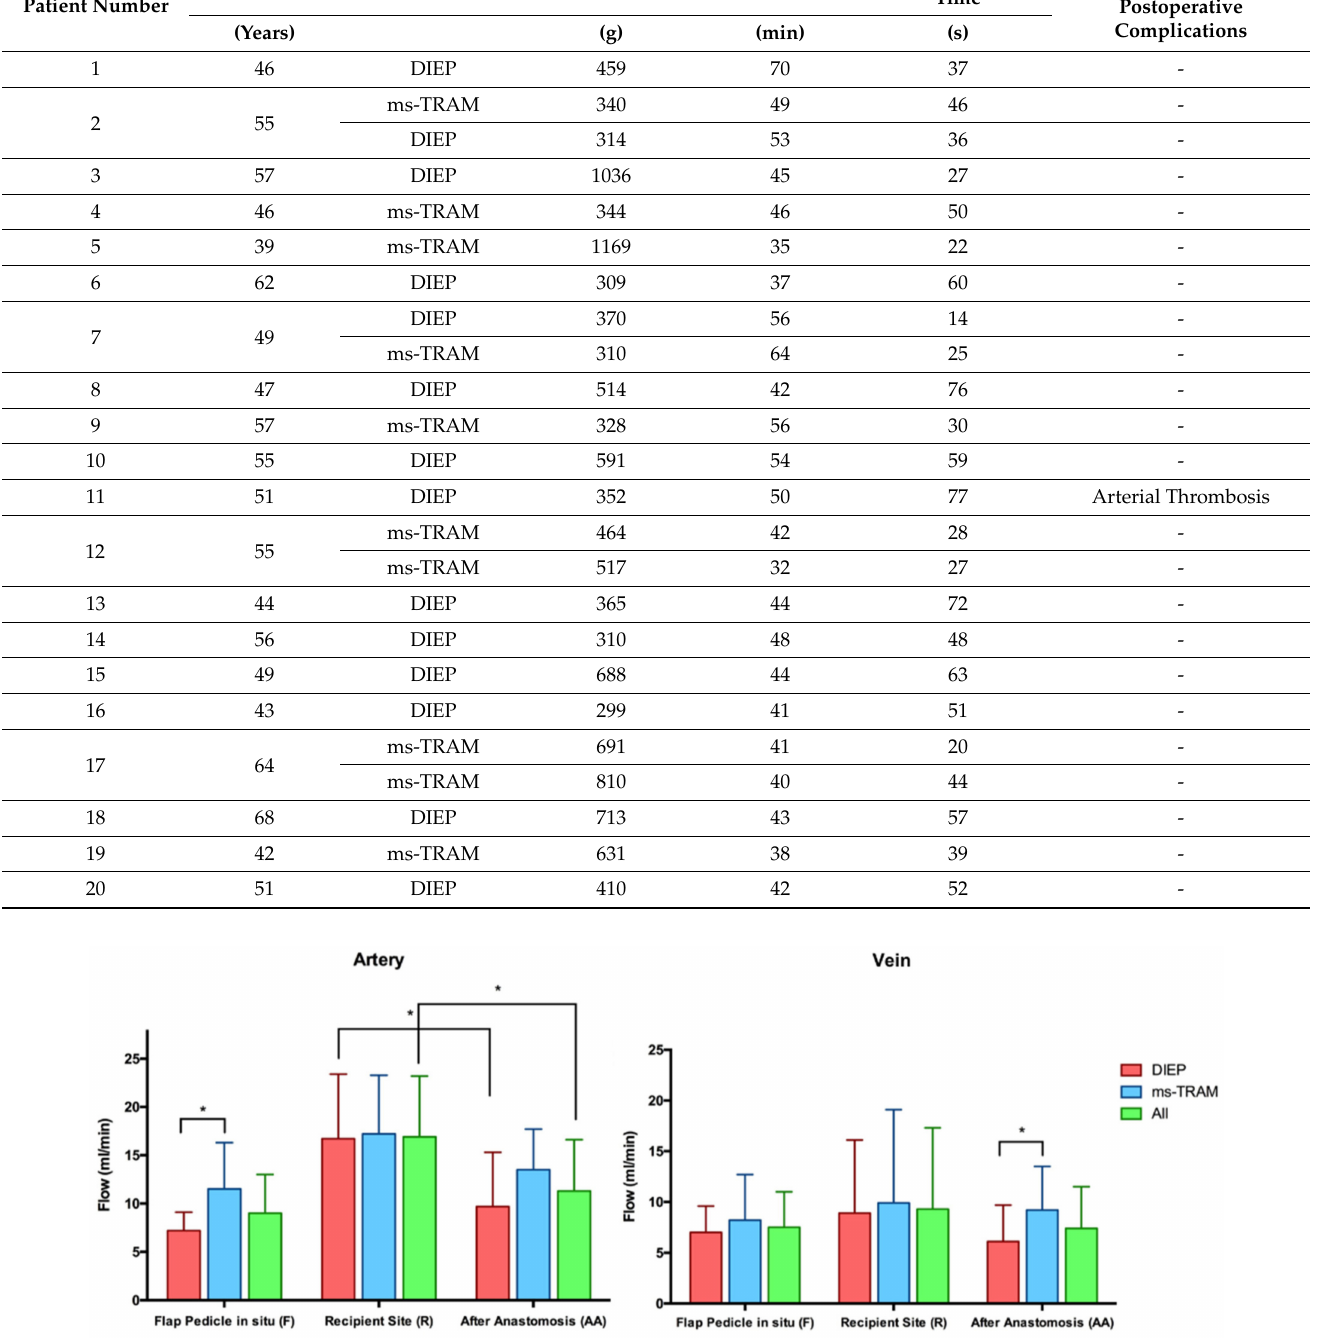
Figure 3. Arterial and venous blood flows (mL/min) at three predefined time points (F, R, AA). The bars represent means ± standard error (* indicates significant